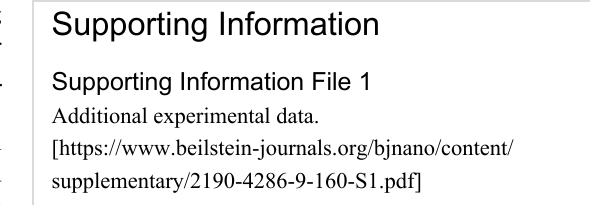
vertically aligned densely distributed